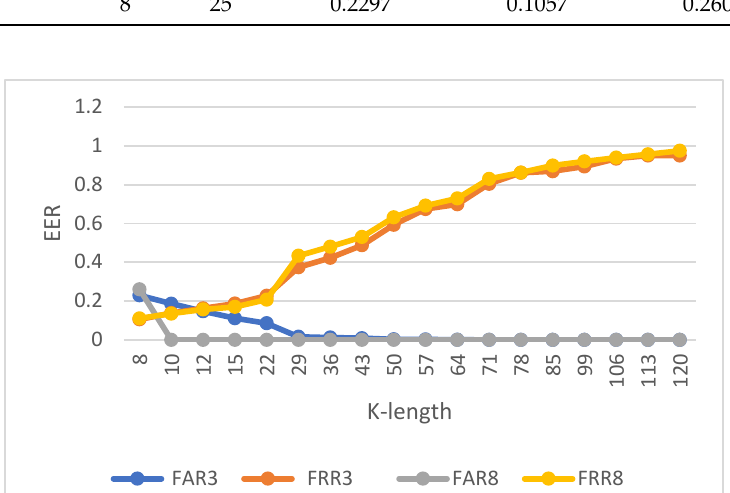
Figure 3. EER with respect to k -length ( k ) of random sampling; FAR3 and FRR3 for three enrollment samples and one authentication sample; FAR8 and FRR8 for eight enrollment samples and three authentication samples.